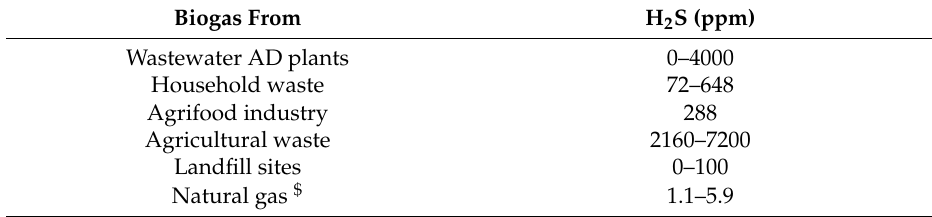
Table 1. H 2 S content in biogas produced by anaerobic digestion (AD) of di ff erent wastes. Adapted from